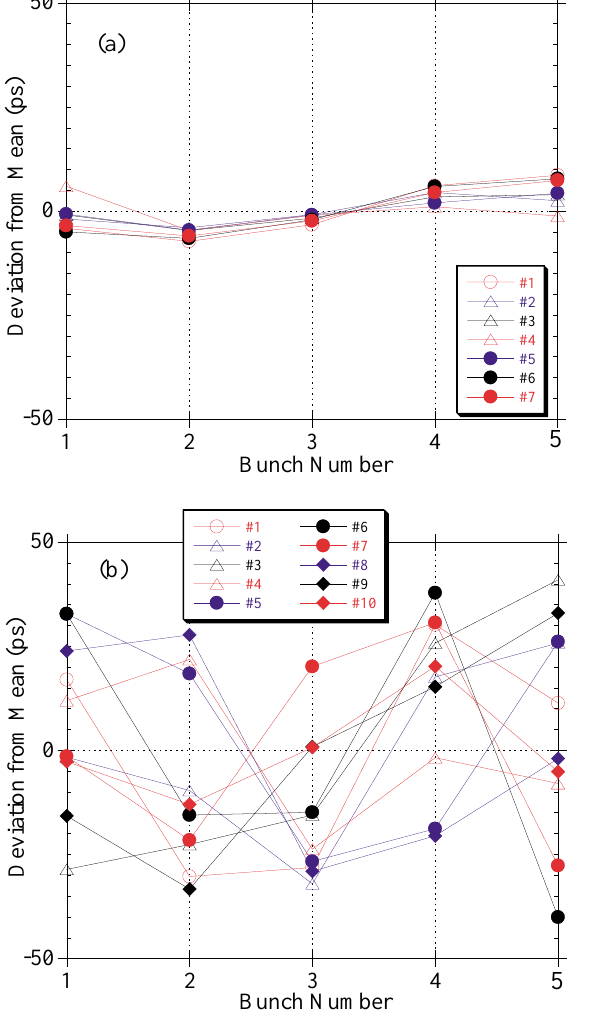
FIG. 34. (Color) The residual from the mean location for the bunches in the train when the bunches are (a) stable and (b) unstable.